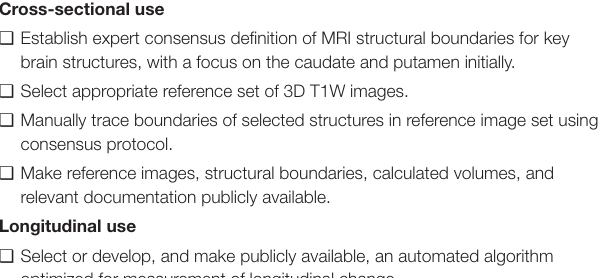
TABLE 3 | Roadmap toward the definition of standard MRI-based anatomical